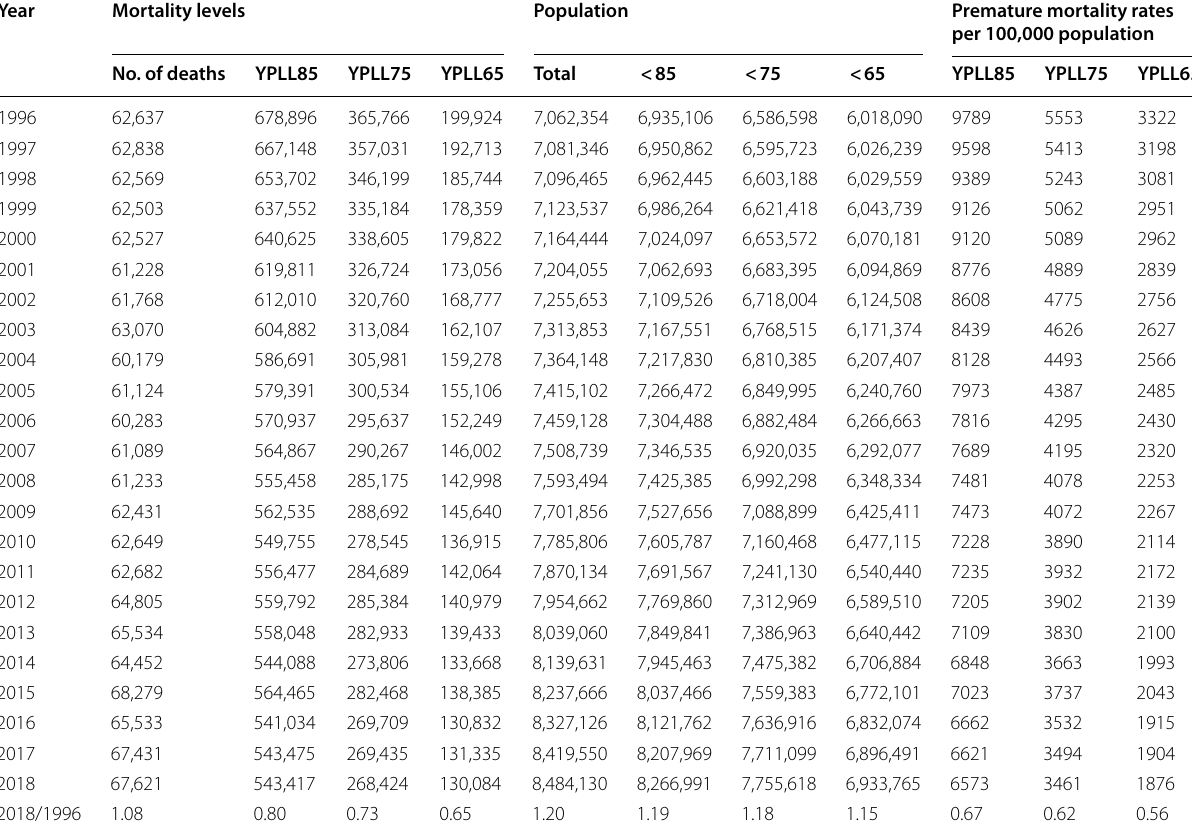
Table 1 Mortality from all causes,